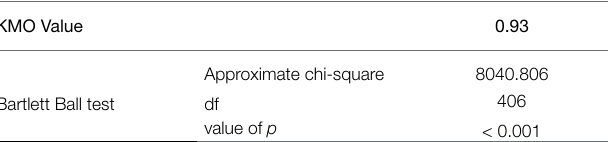
TABLE 2 | KMO and Bartlett Ball